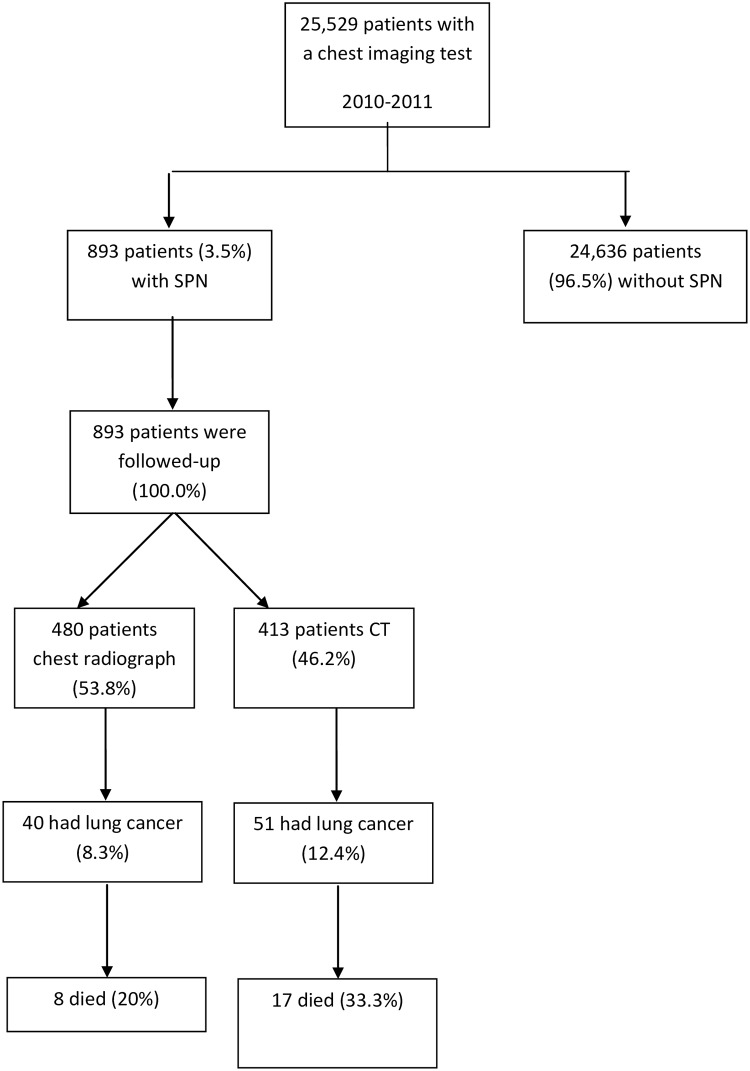
Flow diagram showing the follow-up of the study participants.